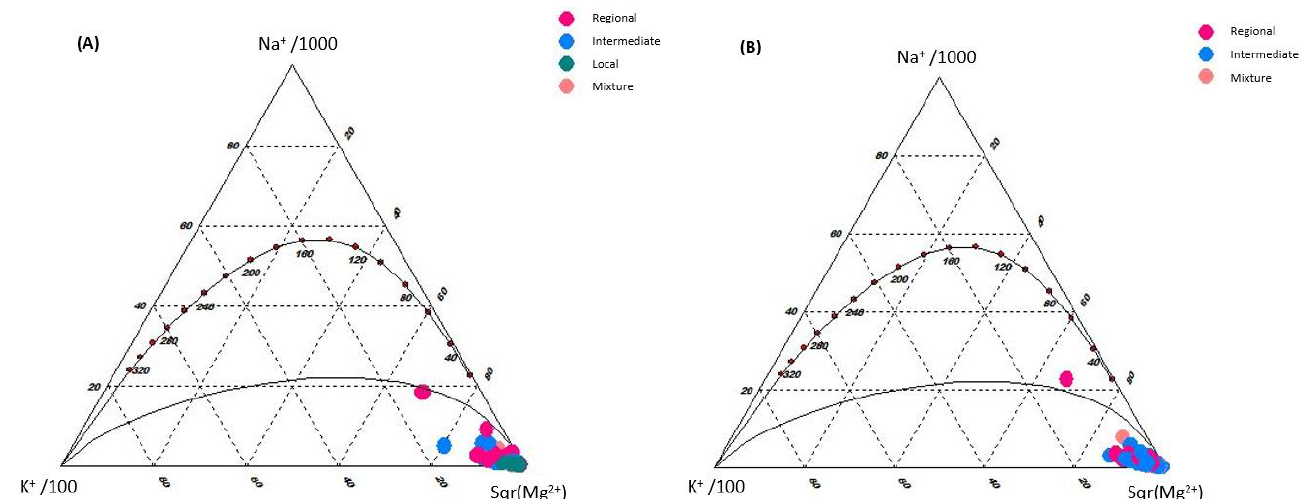
Figure 4. Giggenbach diagram of the different flow systems: ( A ) 2005 and ( B ) 2015.